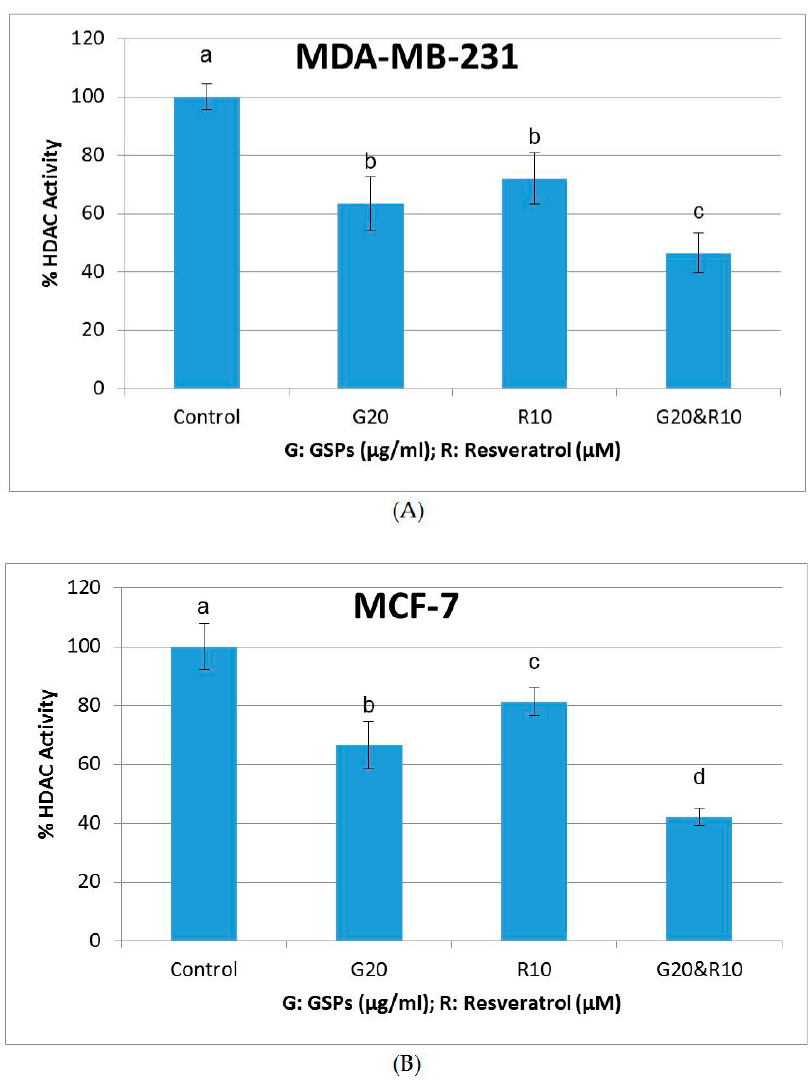
Figure 6. HDAC Activity. Inhibition of HDAC activity in MDA-MB-231 ( A ) and MCF-7 ( B ) human breast cancer cells after treatment with GSPs (20 μ g/ML), Res (10 μ M), and their combination compared with the DMSO-treated control groups for 48 h. Results were generalized from three independent experiments with very similar observations. The HDAC activity of each treatment group is represented in percentage as compared with the control group as the mean ± SD. Mean values without any same superscript letter were considered significantly different ( p < 0.05).